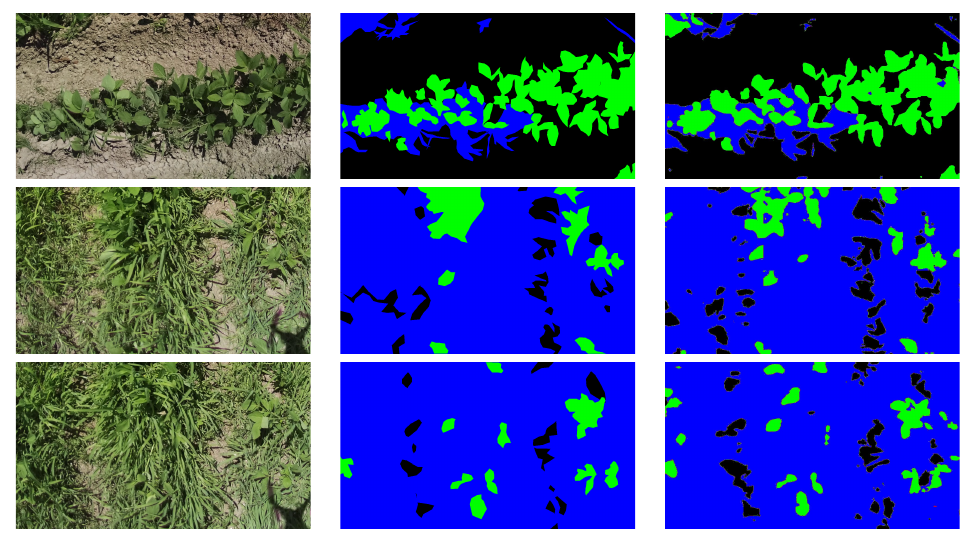
Figure 20. Representative successful Soybeans images: source images ( left ), GT ( center ), and re- sults ( right ).